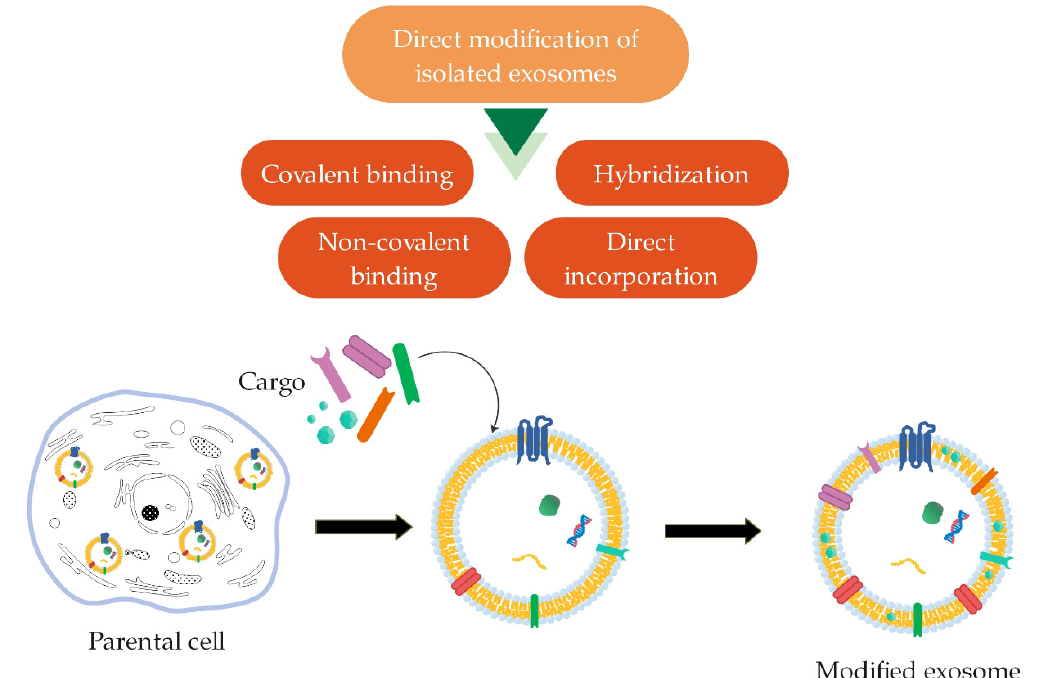
Figure 7. Direct surface modification of isolated exosomes using different methods (covalent binding, non-covalent binding, hybridization, and direct incorporation; summarized from [16,85]).